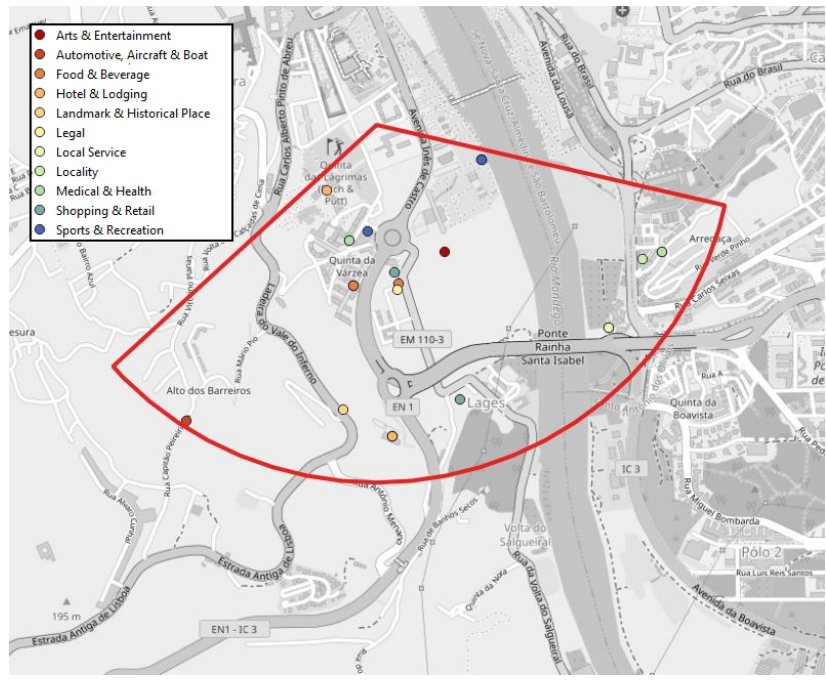
Figure 4. Example of an antenna’s signal